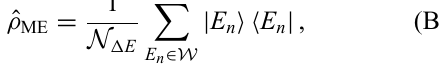
(cid:3) given on top. LPG protection stabilizes 0 Z 2 gauge